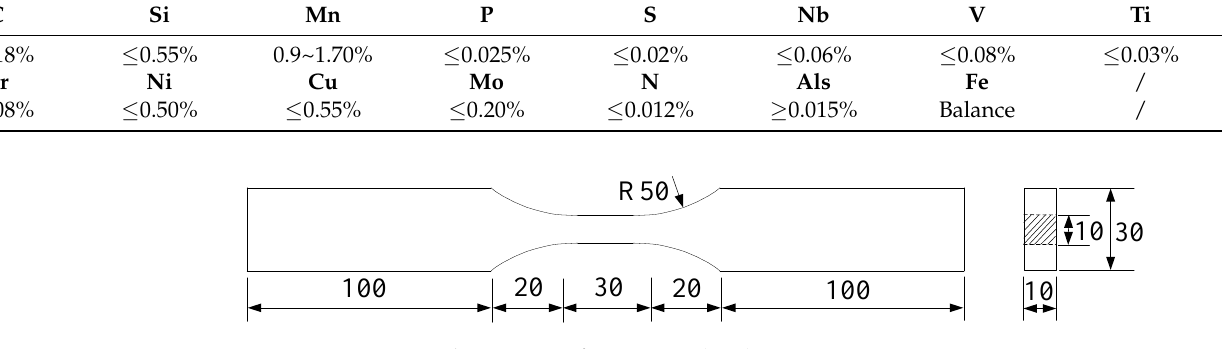
Figure 1. Geometric dimensions of specimens (mm).